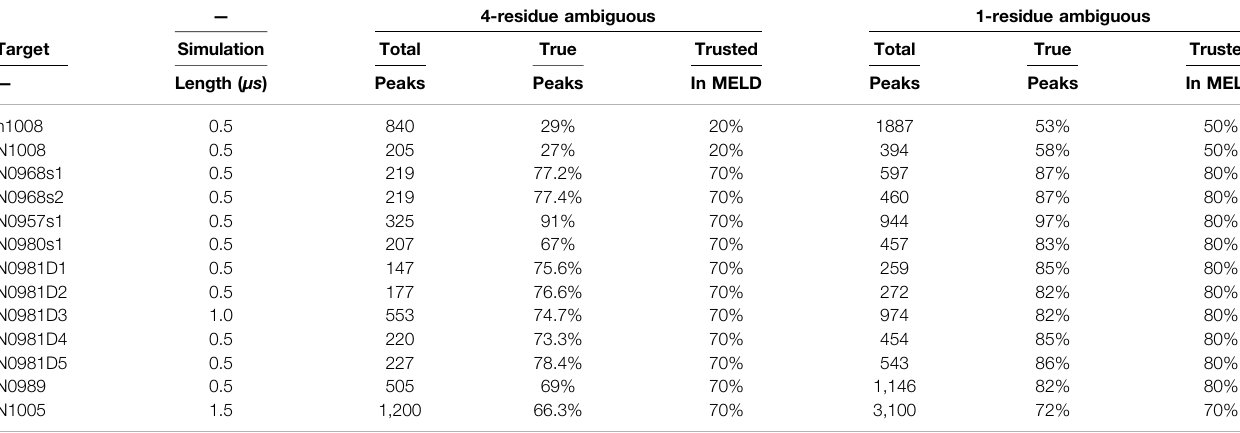
TABLE 1 | Noise in NMR datasets and